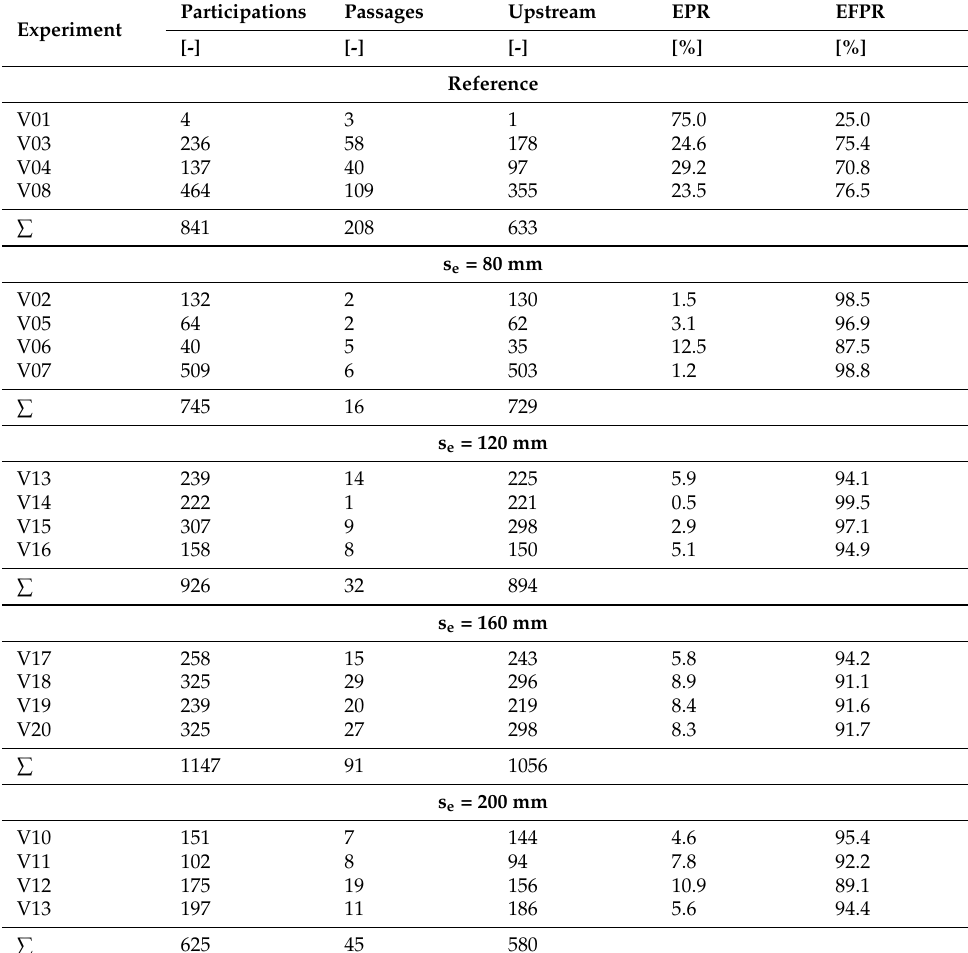
Table A2. Video analysis results of the ethohydraulic experiments, participation = number of fish crossing the 40 cm line in downstream direction, passages = number of fish passing through the bar rack in downstream direction, upstream = number of fish leaving the area in upstream direction, EPR = experimental passage rate (=passages/participations), EFPR = experimental fish-protection rate